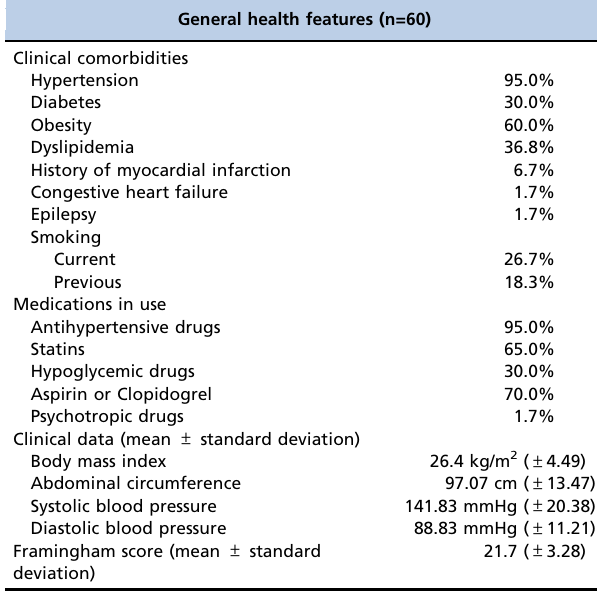
Table 2 - General health features of a sample of 60 patients after ischemic acute